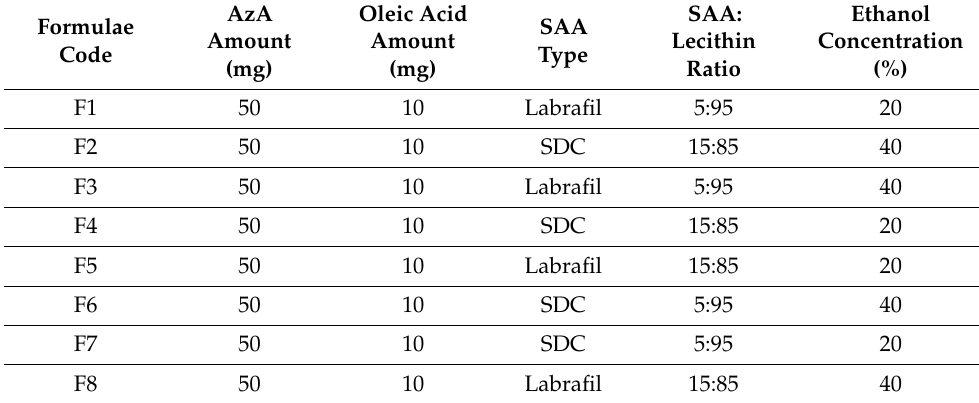
Table 2. Composition of the prepared TEs loaded with